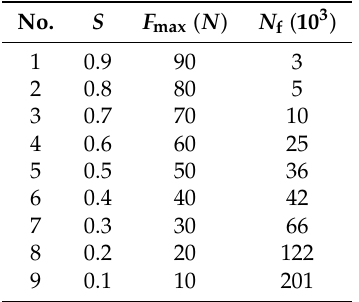
Table 1. Stress level of load and corresponding fatigue